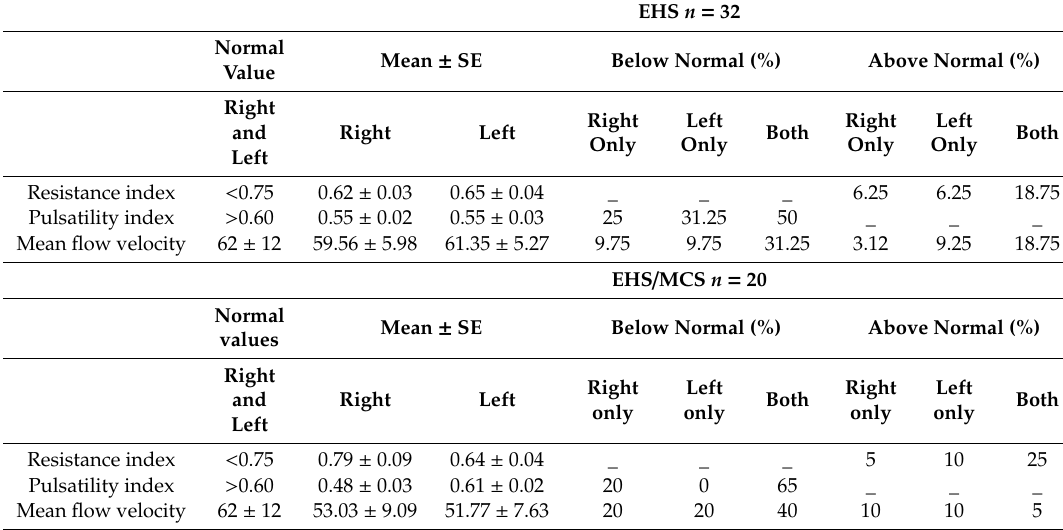
Table 7. Results of resistance index, pulsatility index, and mean flow velocity in comparison with normal values in the right and left middle cerebral arteries using transcranial Doppler ultrasound in 32 EHS cases and 20 EHS / MCS cases (unpublished